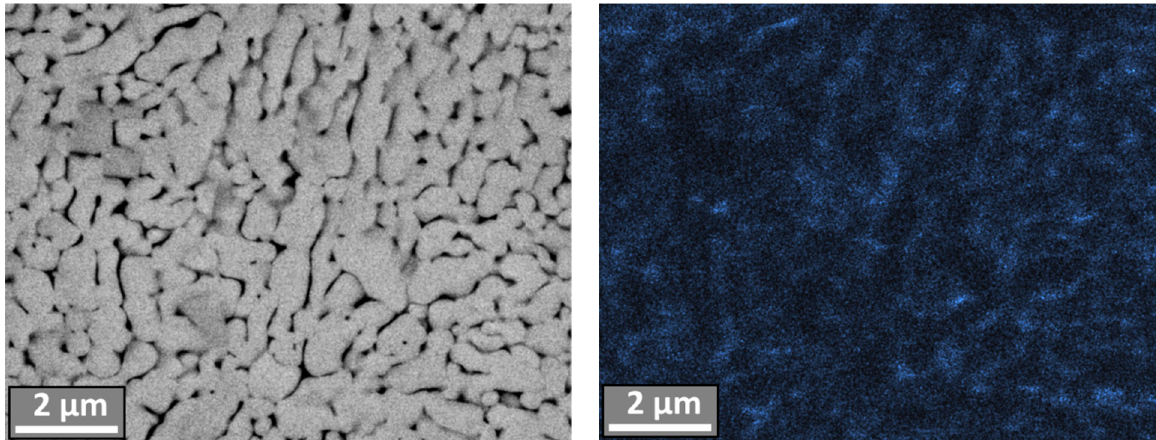
Figure 10. SEM image of W-C-Co spheroidized micropowder cross-section and map of Co distribution in this cross-section.